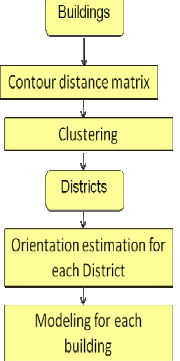
Figure 3 main orientation